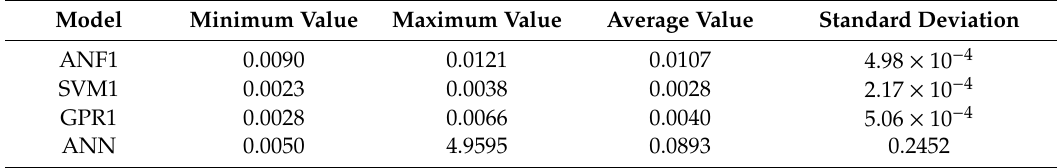
Table 8. Comparison of statistical RMSE data for training 1000